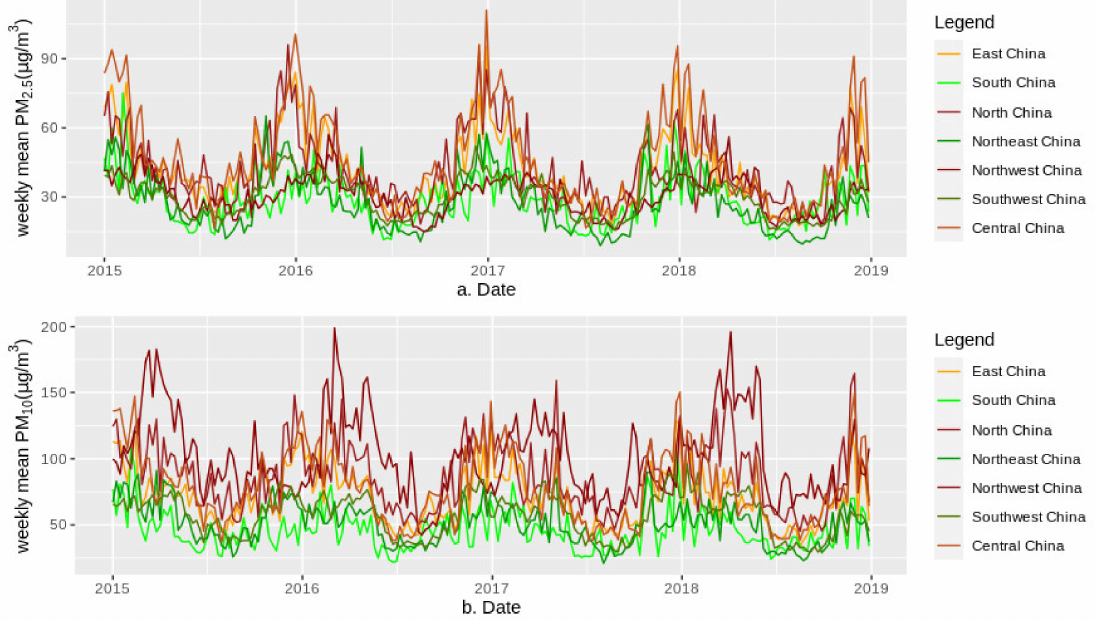
Figure 12. Weekly means of predicted PM 2.5 ( a ) and PM 10 ( b ) concentrations from 2015 to 2018 for seven geographical regions in mainland